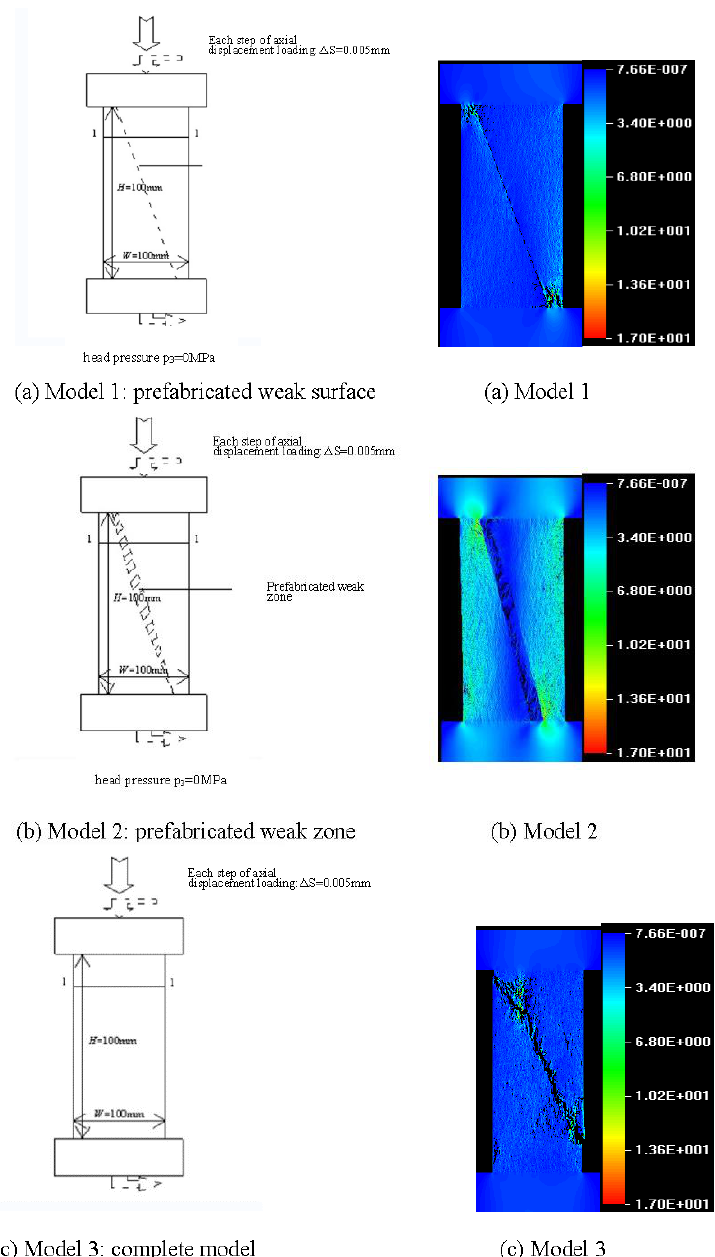
Figure 5. Loading diagram of the numerical simulation test and image of the model failure stress (MPa).